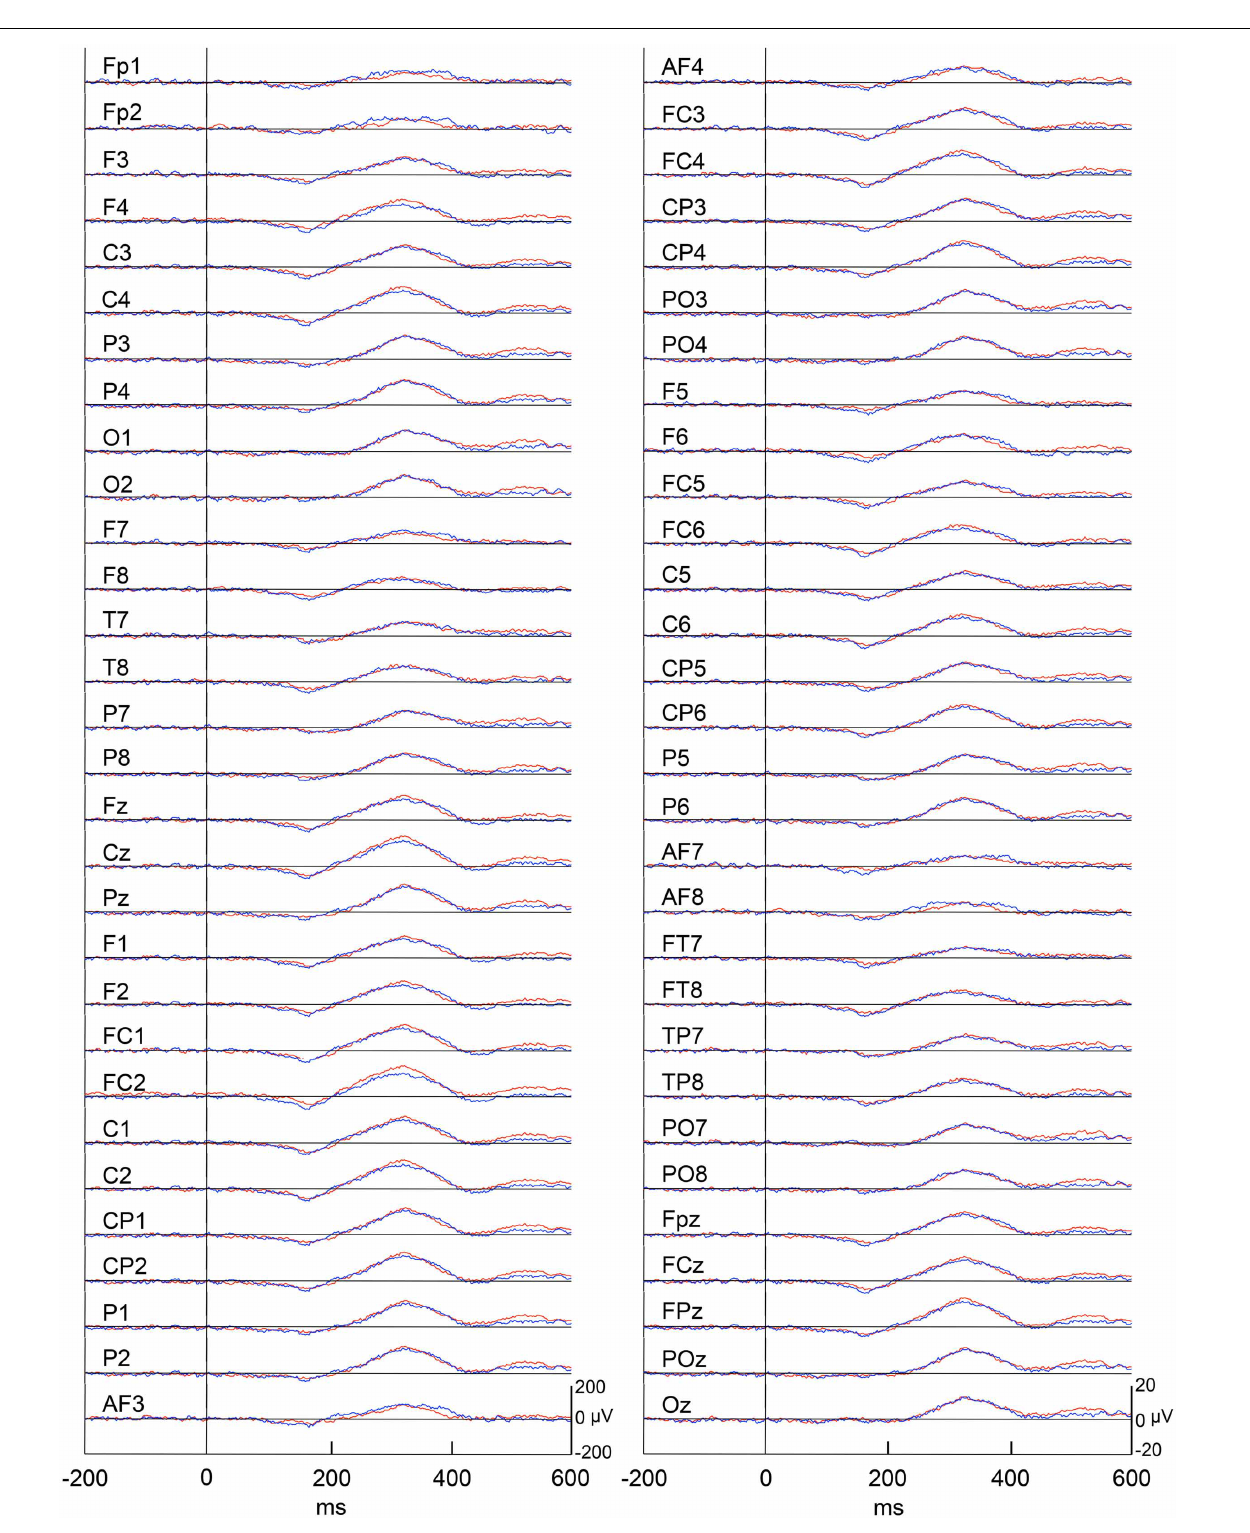
FIGURE 7 | Averaged ERPs with vertex-positivity in the test phase. Blue and red recordings indicate averaged ERPs in the first and third trials in the test phase, respectively. Zero in time scale indicates arrival at the spatial reference points.